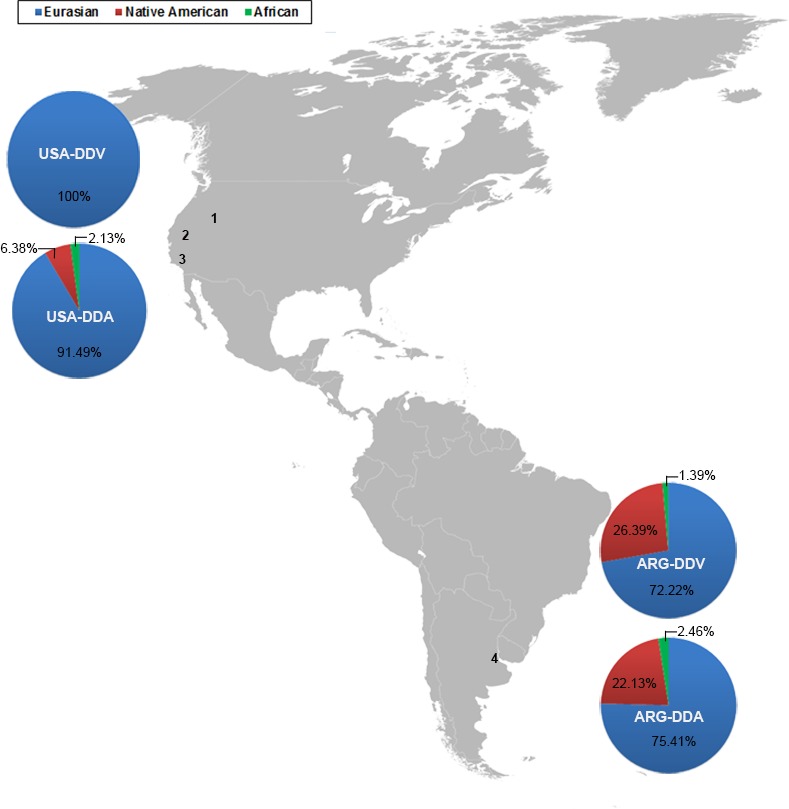
Distribution of Eurasian, Native American and African lineages in the Basque Diaspora populations.Geographical origin of samples is indicated by a number, Boise (1), Reno (2), and Chino (3) from USA, and Buenos Aires province (4) from Argentina. Adapted from Wikimedia Commons (https://commons.wikimedia.org/wiki/File:America-blank-map-01.svg); photo of Blank Politic Map of Americas by DavoO, under the Creative Commons Attribution License (CCAL) CC BY 3.0.